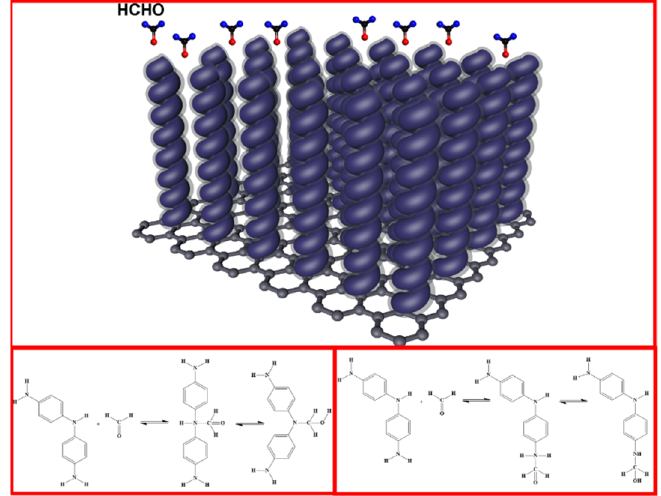
Figure 12. The mechanism of the 3-PANI-CNCs.